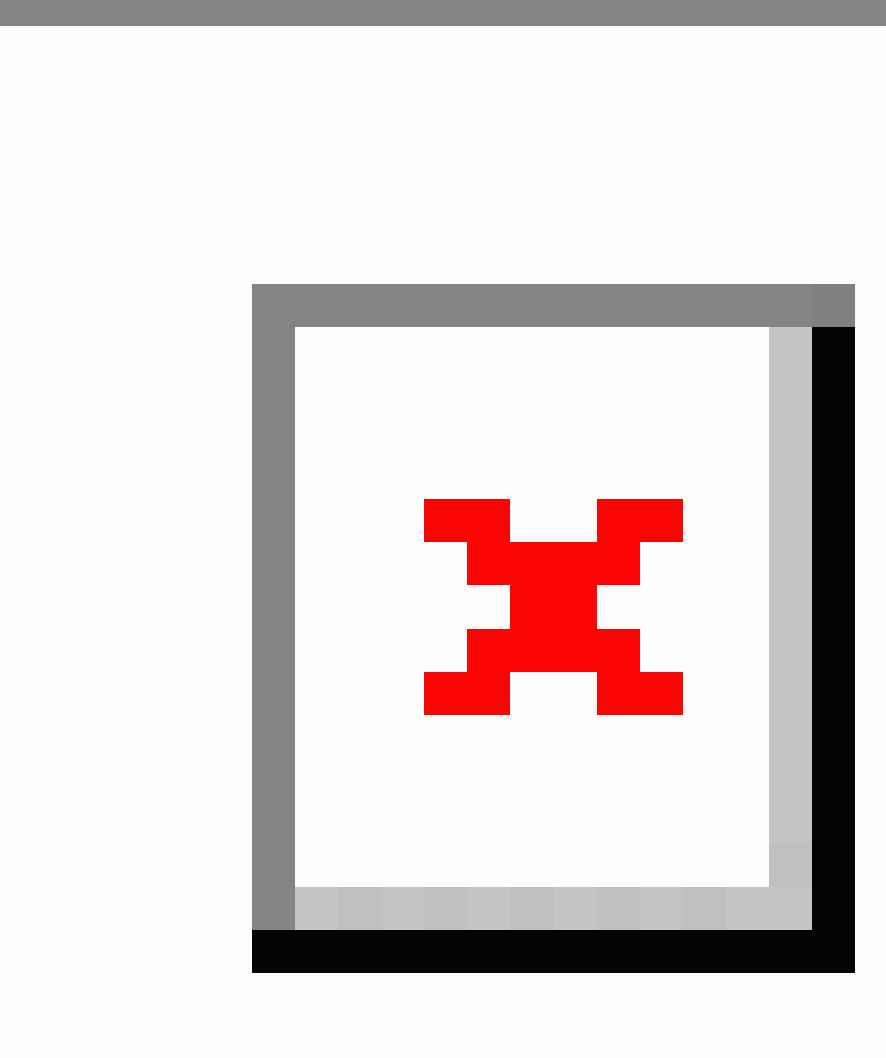
Figure 3. A screenshot of one of the Focus Pocus